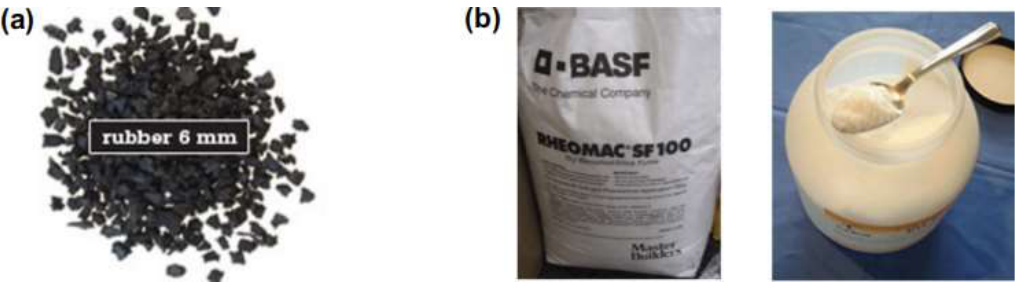
Figure 15. Material samples selected for test samples. ( a ) Rubber crumbs. ( b ) Silicon powder [7].